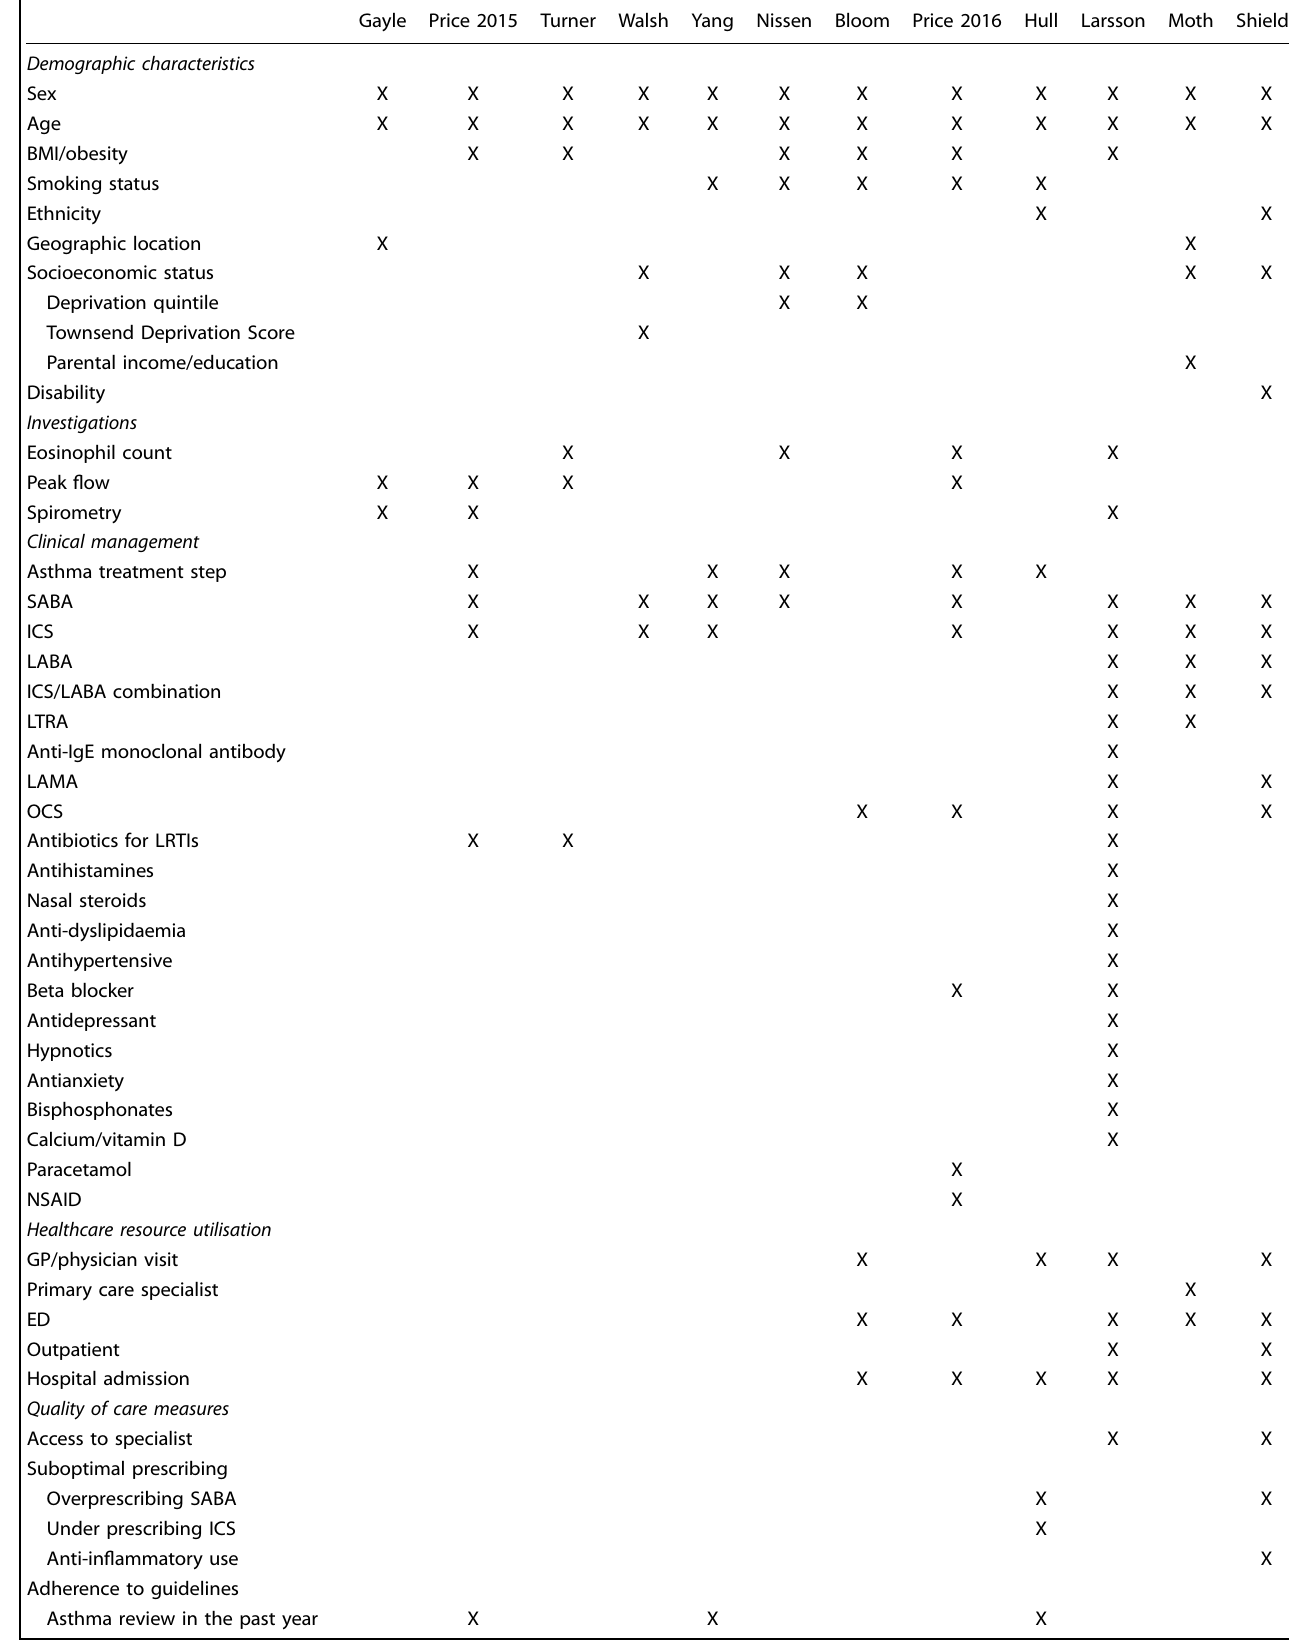
Table 4. Recurring themes analysed in the included articles using available